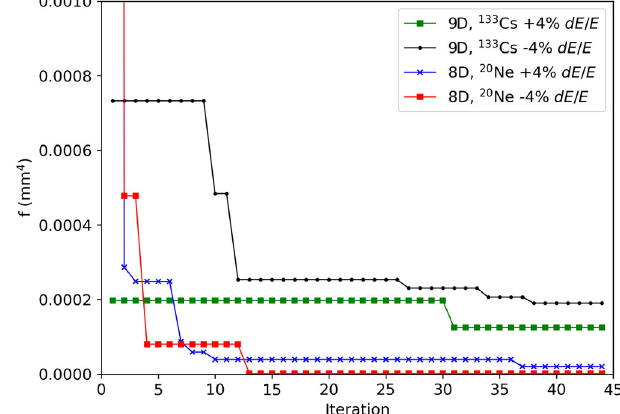
FIG. 5. Objective function defined in Eq. (3) reached as a function of number of GP iterations, for 8D (seven quadrupole and one hexapole magnets) and 9D (seven quadrupole and two hexapole magnets) optimizations within (cid:3) 4% dE=E .